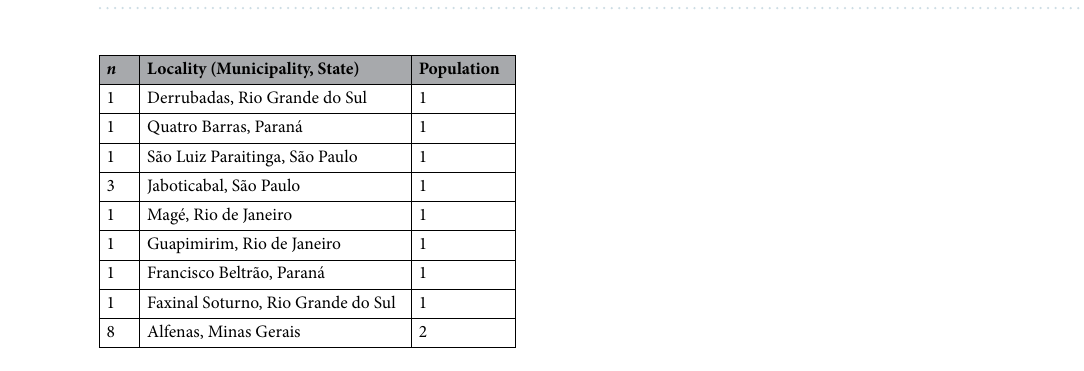
Figure 2. Flowchart of decision making for microsatellite analyses explains the decision-making pathway considering possible different scenarios and analyses biases.